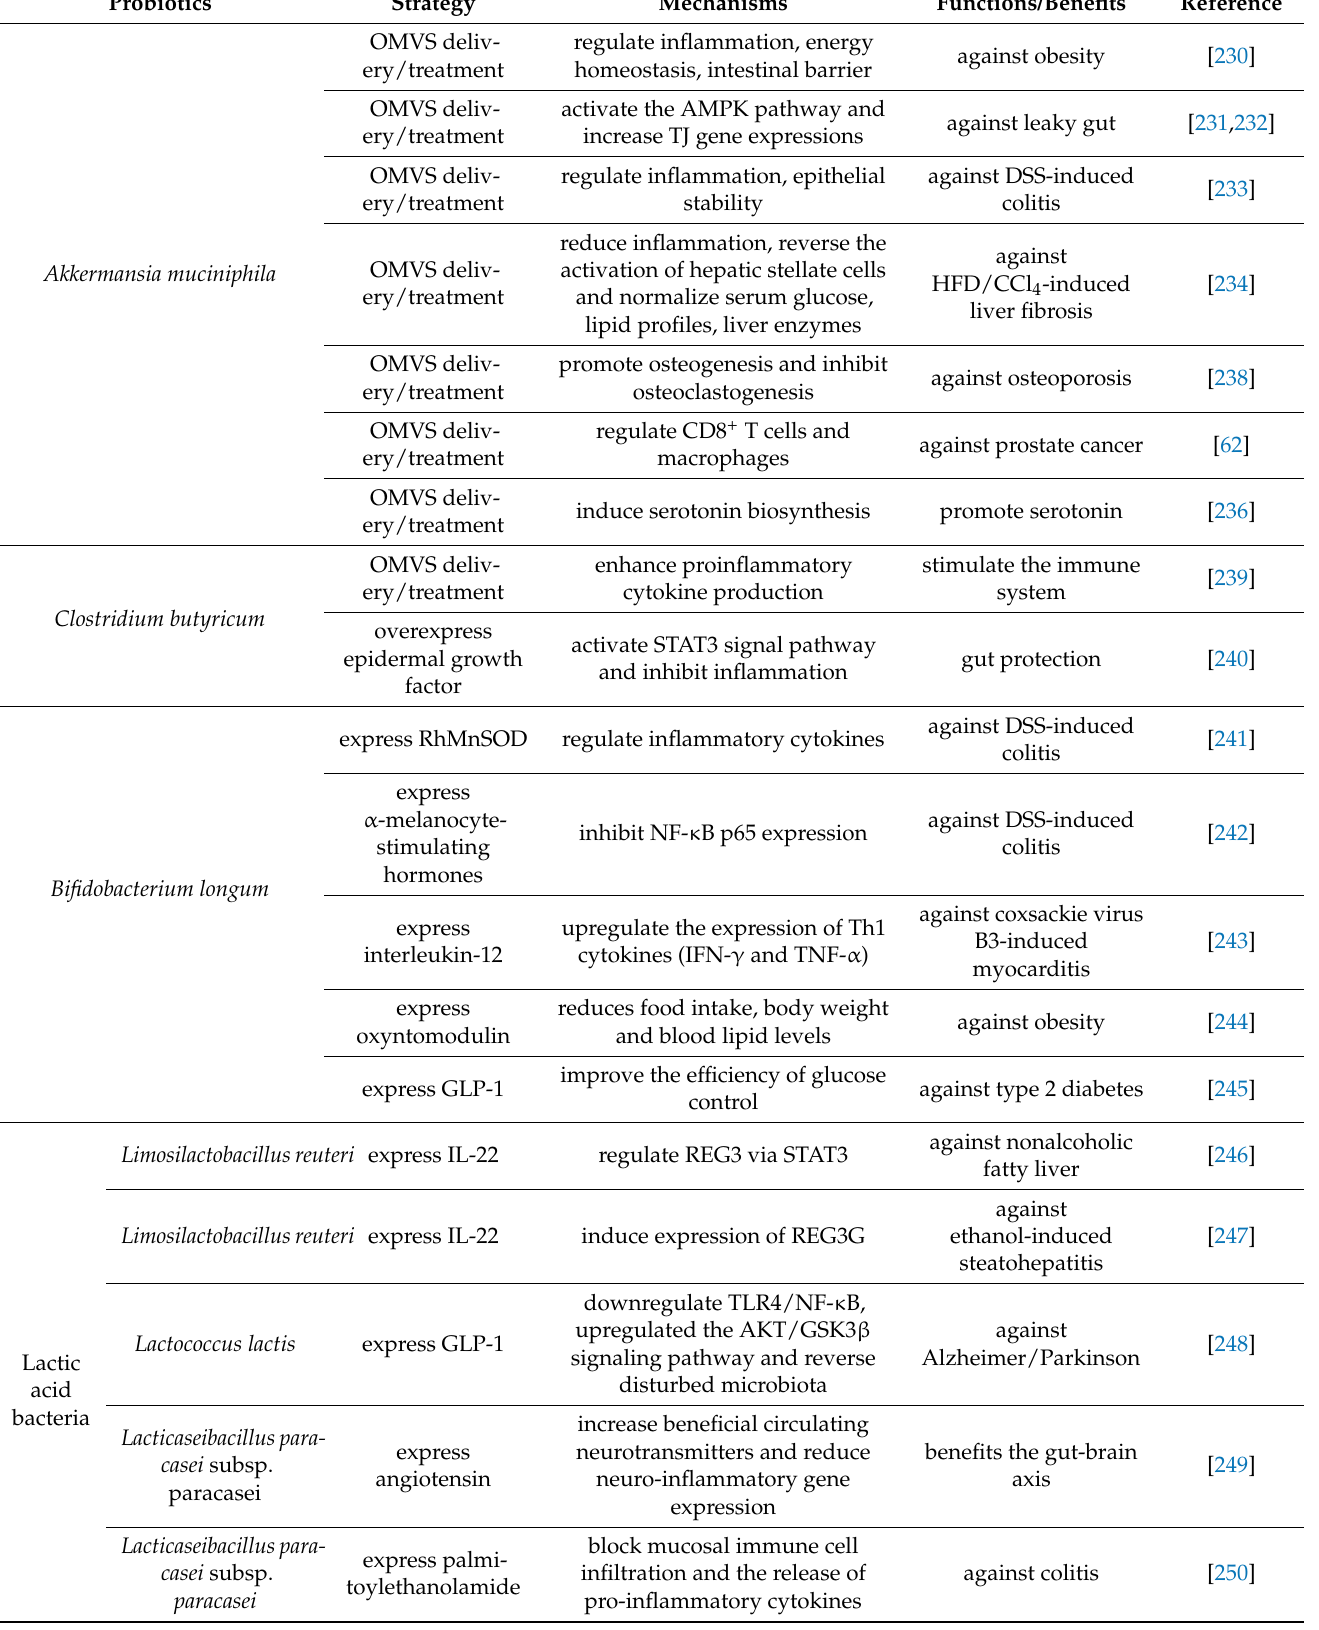
Table 2. The strategy of modified probiotics or probiotic derivatives in the treatment of diseases.